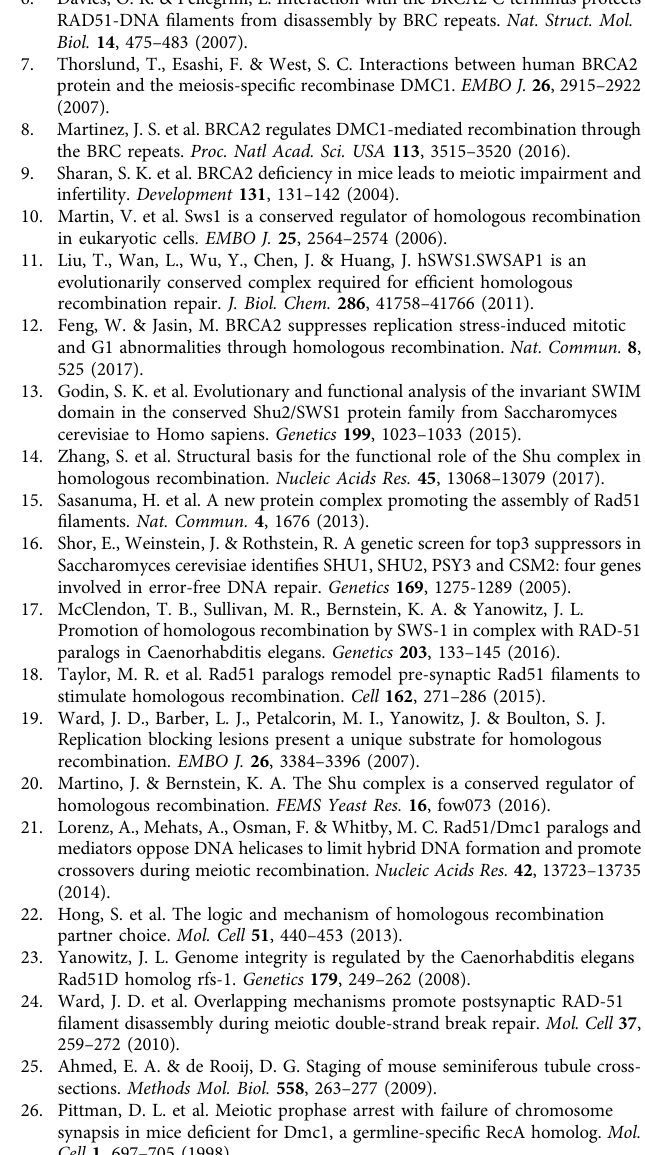
Fig. 5 BRCA2 C terminus promotes Swsap1 spermatocyte progression. a Swsap1 − / − ( + 1) Brca2 Δ 27/ Δ 27 spermatocytes do not progress past early